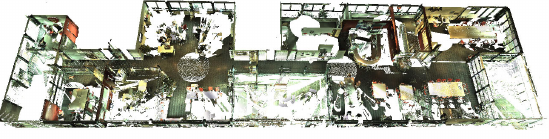
Figure 7. Case study 3 (clipped